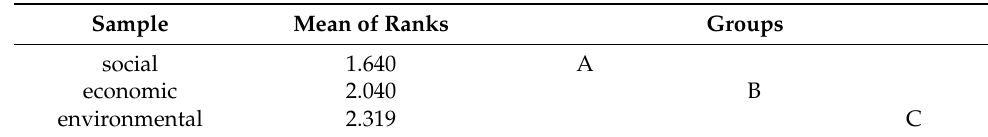
Table 2. Results of pairwise comparisons (Nemenyi’s procedure) illustrating significant differences in assessing the importance of the selected components in sustainability.